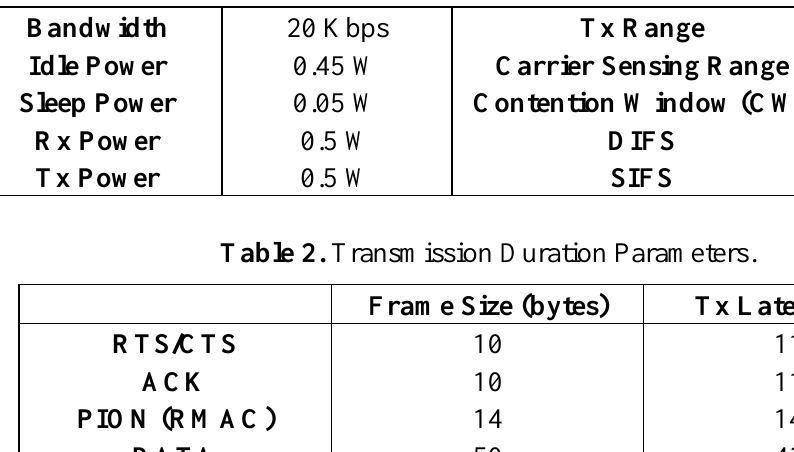
Table 1. Networking Parameters.